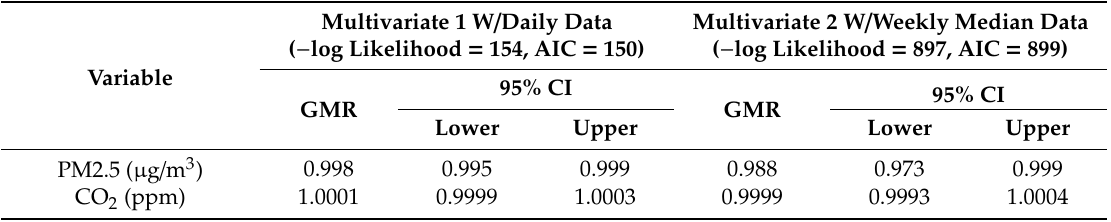
Table 4. Multivariate geometric means and 95% confidence intervals of indoor air quality and asthmatic children’s